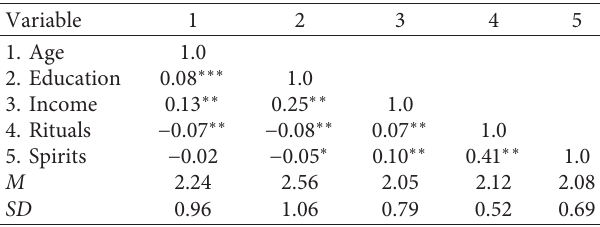
Table 3: Bivariate correlations and descriptive statistics among main study